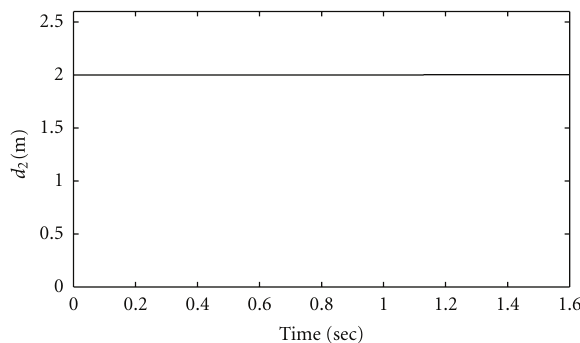
Figure 8: Plot of distance between first follower and ordinary follower 1 versus time.